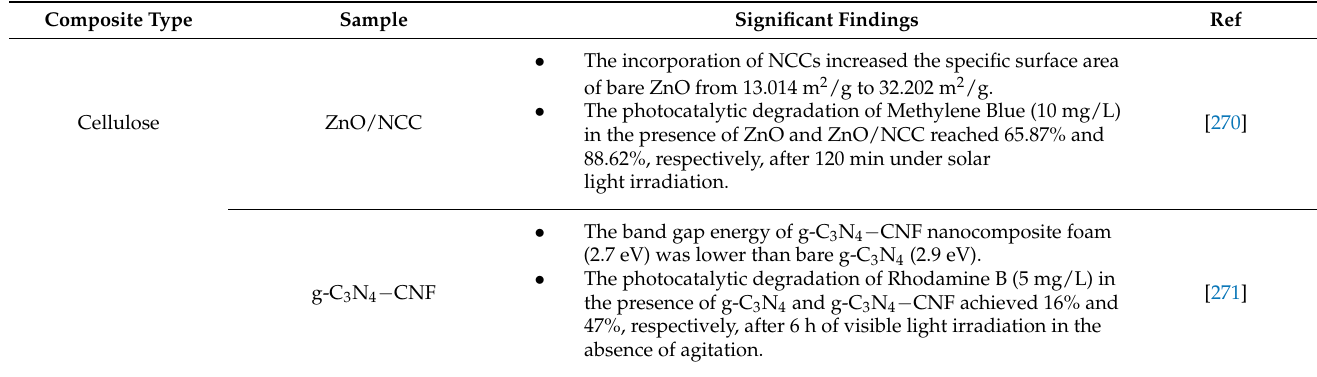
Table 6. Significant findings on the performance of cellulose-based photocatalysts in the degradation of